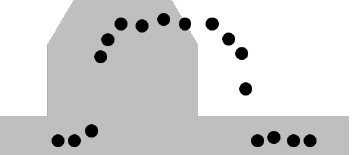
Figure 3. Representation of a DSM (a building), in grey, and a set of points of the same objects, from the sparse cloud.